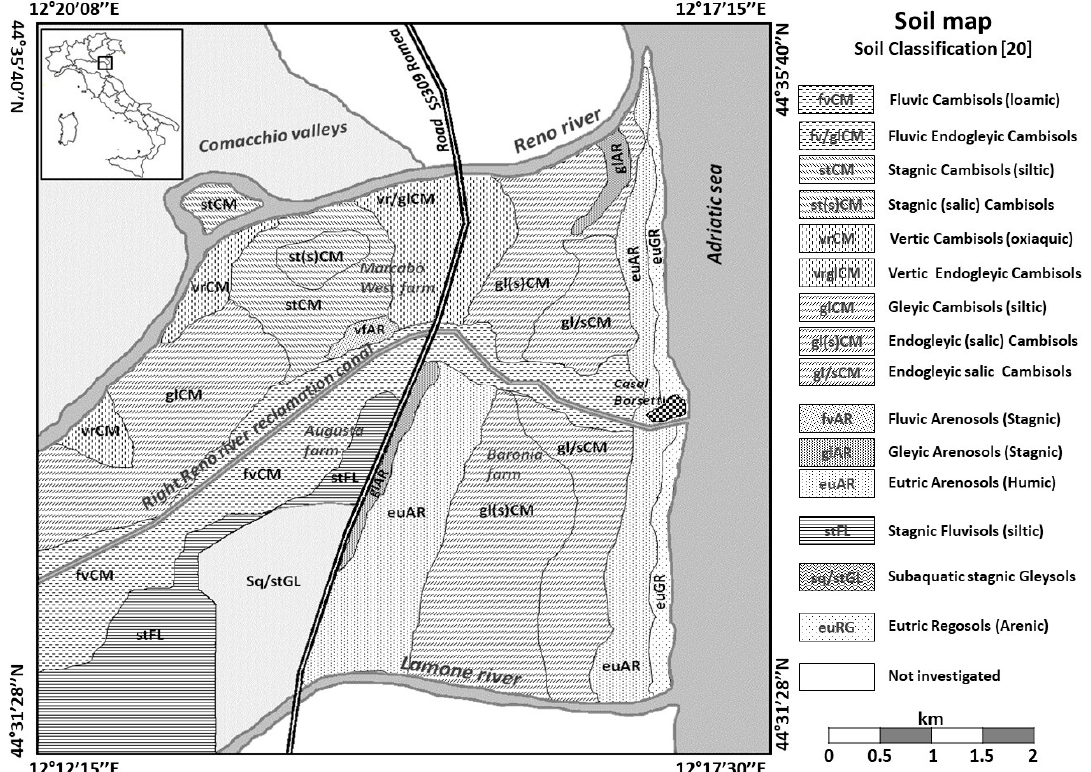
Figure 2. Soil map of the study area.